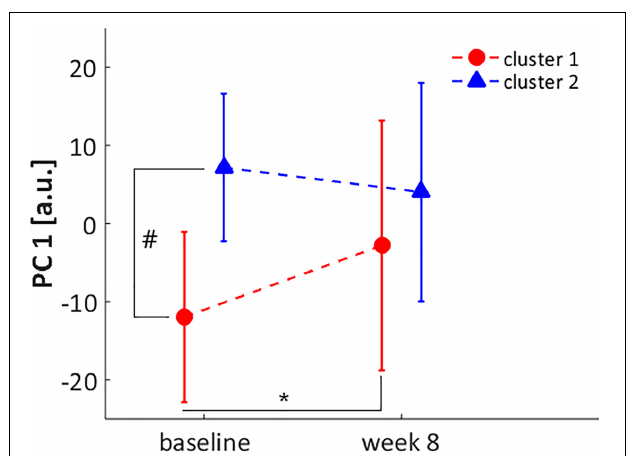
FIGURE 7 | Score for PC1 at baseline and week 8 assessments for cluster 1 (red circle) and cluster 2 (blue triangle). * significant difference between baseline and week 8 assessment in cluster 1. # significant difference between cluster 1 and 2 at